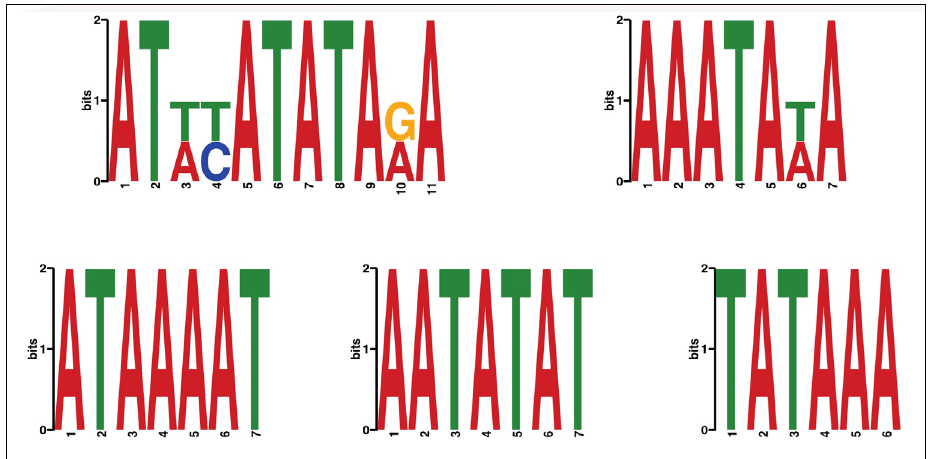
Figure 2. AT-rich binding motifs as potential response elements for the transcription factor AKNA, with possible A/T, T/C, G/A nucleotide changes identified with the MEME-ChIP tool (E value < 0.05).